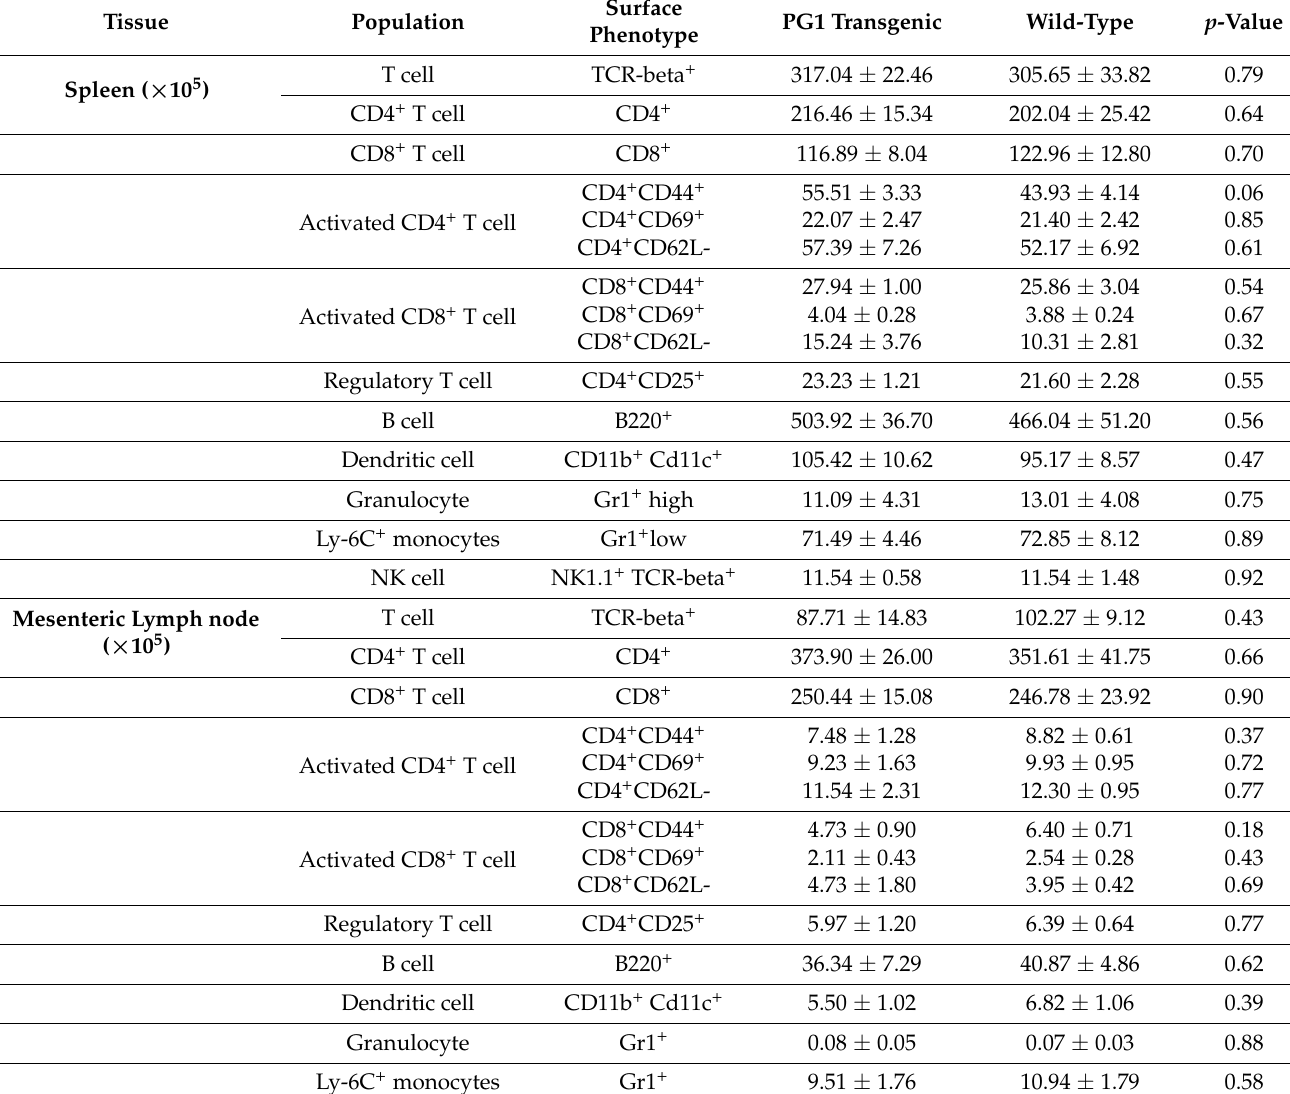
Table 1. Absolute numbers of immune cells in protegrin 1 (PG1) transgenic and wild-type mice.